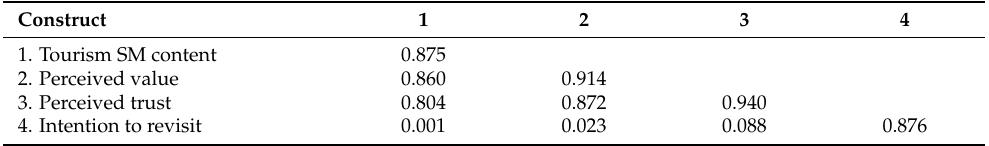
Table 3. Outcomes of the discriminant validity. Construct